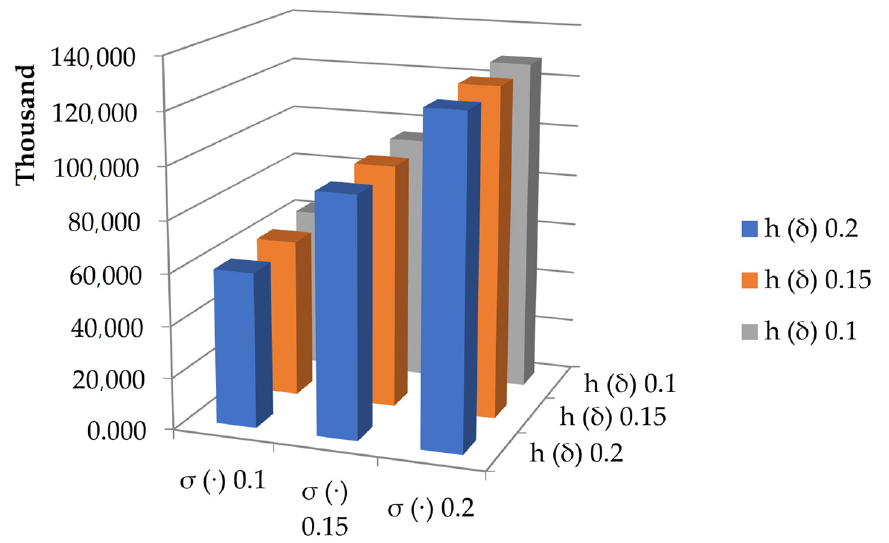
Figure 5. The Subordinate’s objective function using P.B.I.M. with different Principal’s control parameters of stimulation and loss functions.